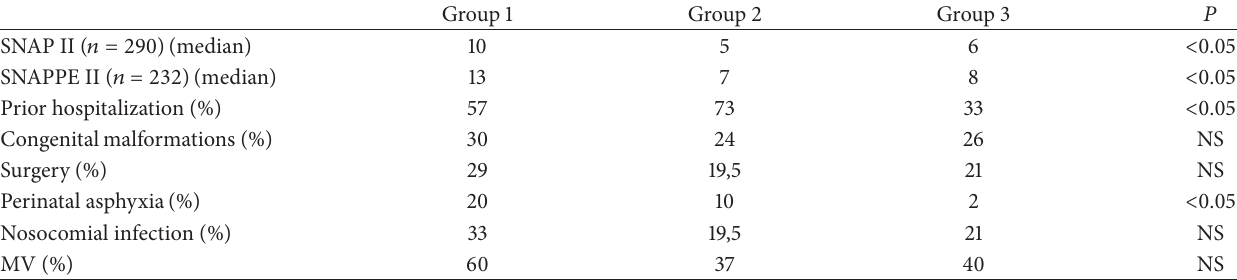
Table 2: Mortality risk factors in each group studied. MV (mechanical